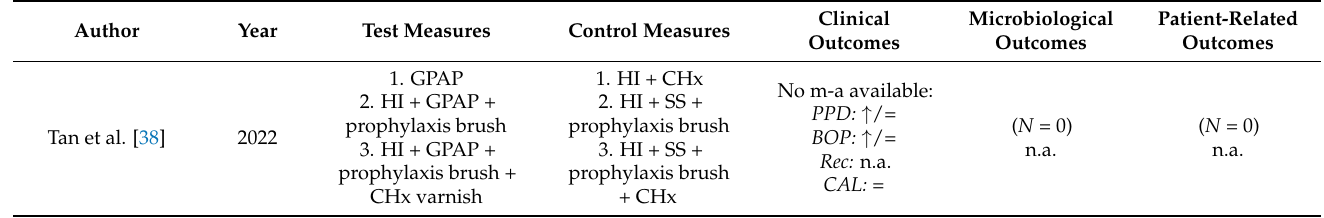
Table 5. Results of the included systematic reviews on supportive peri-implantitis therapy (PIT) and peri-implant mucositis therapy (PIM). (BOP: bleeding on probing reduction; CAL: clinical attachment level gain; CHx: Chlorhexidine; GPAP: glycine powder air polishing; HI: hand instruments; M-a: meta-analysis; N: number of included studies; n.a.: not available; PPD red: periodontal pocket depth reduction; Rec: gingival recession; SS: sonic scaler; =: no difference; ↑ : (*significant) better results in the test group; ↓ : (*significant) worse results in the test